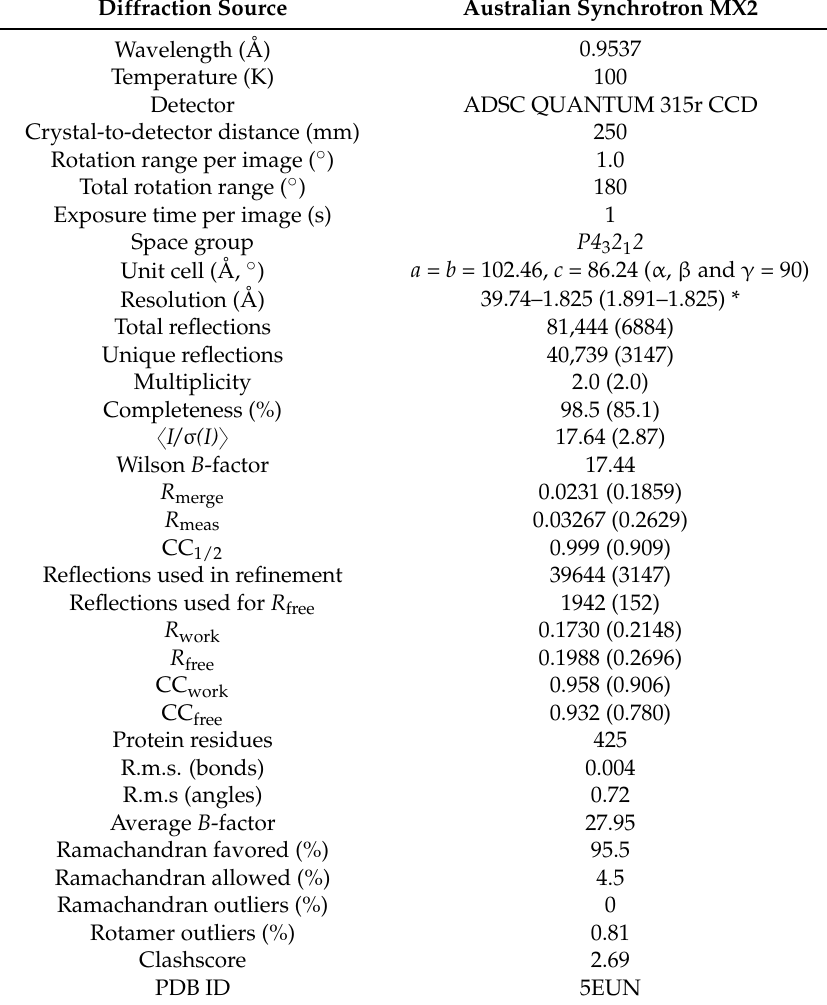
Table 4. Data collection and refinement